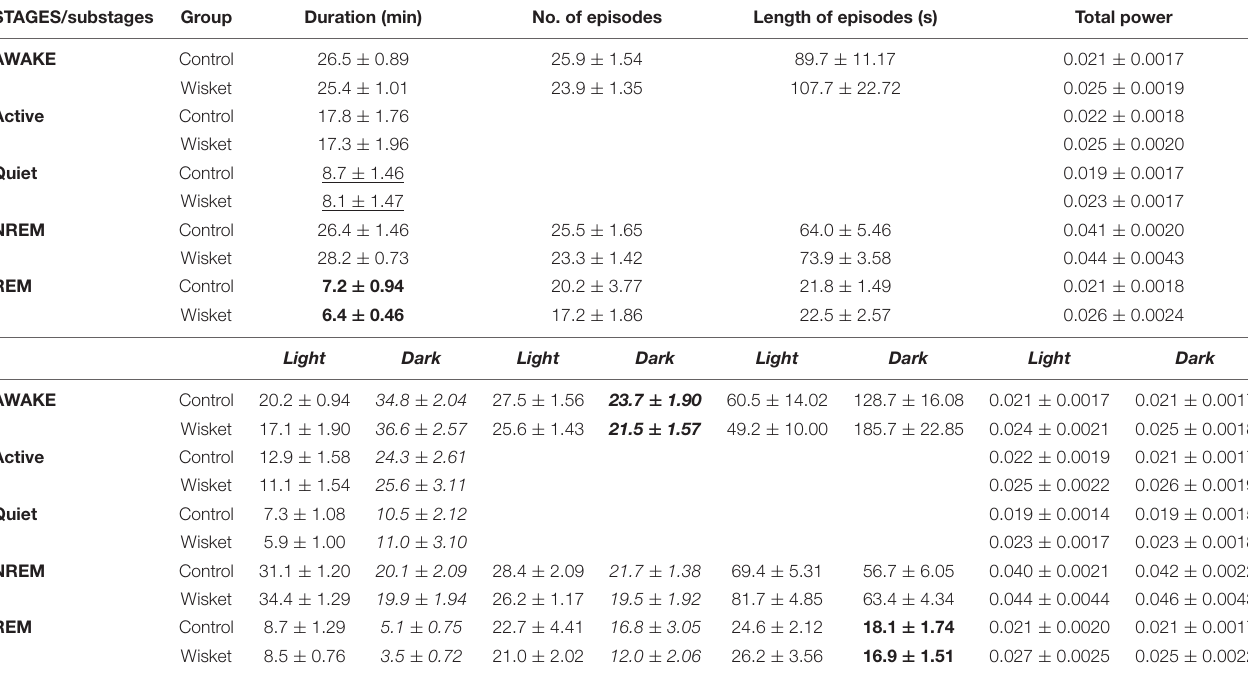
TABLE 1 | The mean per hour ◦ ± ◦ SEM duration of different stages and substages, the number and length of episodes in control and Wisket animals for the whole period and by light and dark phases. STAGES/substages